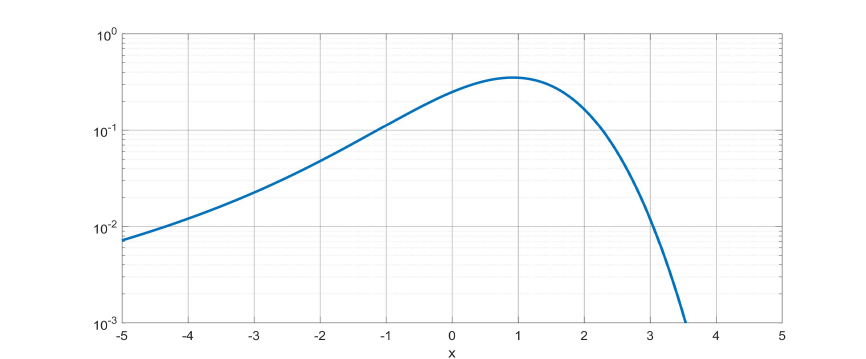
Figure 4. Plot of the bilateral extremal stable pdf for α =